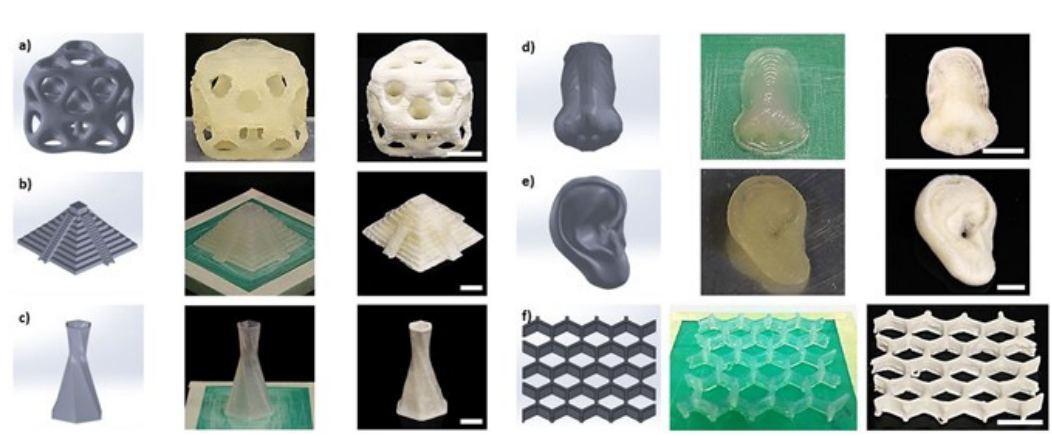
Figure 2. Direct ink write (DIW) 3D-printed ( a ) octet cube, ( b ) pyramid, ( c ) hexagonally twisting vase, ( d ) nose model, ( e ) ear model, and ( f ) honeycomb from 20 wt.% cellulose nanocrystal (CNC) gel and 500 µm nozzle tip. The first column is a Computer-Aided Design (CAD) model, the second column is DIW 3D-printed gel structures, and the third column is the resultant structures after freeze-drying. Displayed scale bars are 1 cm. (Adapted from Scientific Reports, Vol. 5, Vincent Chi-Fung Li, Conner K. Dunn, Zhe Zhang, Yulin Deng and H. Jerry Qi, Direct Ink Write (DIW) 3D Printed